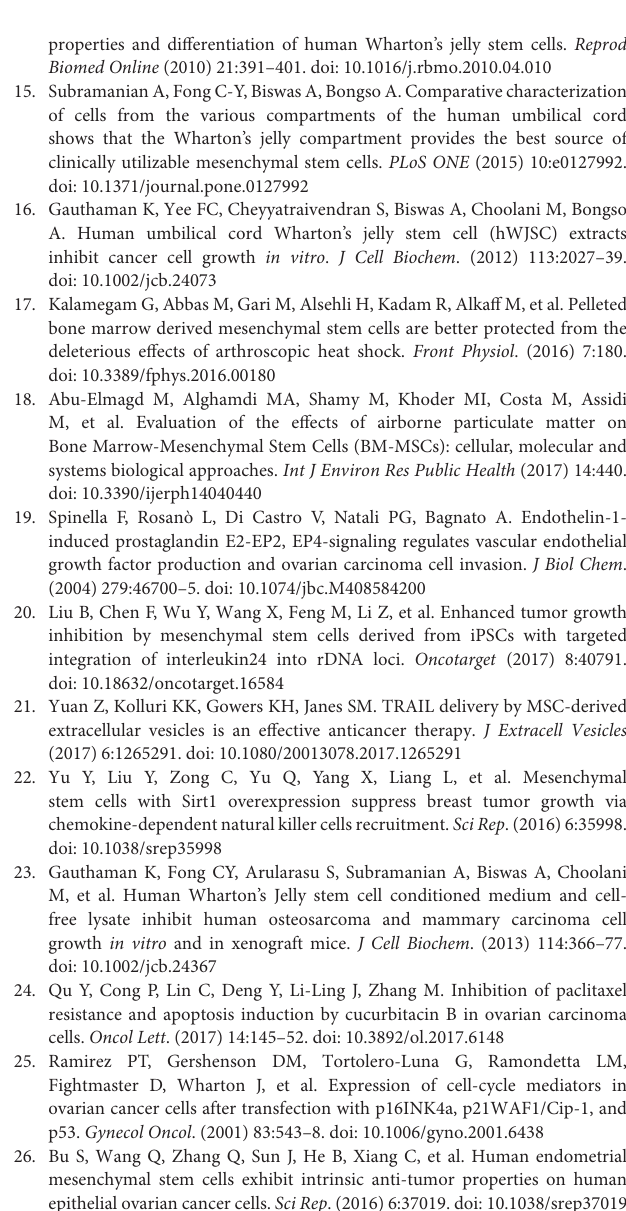
Supplementary Figure 1 | Representative phase contrast images of OVCAR3 cells treated with paclitaxel (A) and OVCAR3 cells treated with doxorubicin (B) . There were more cell death and decreases in OVCAR3 cells with increasing